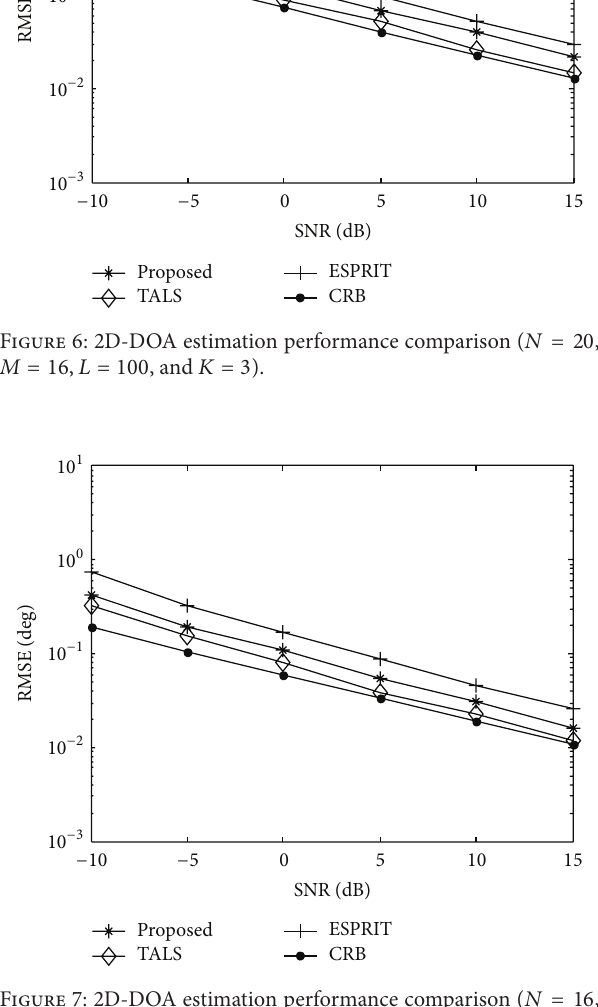
Figure 7: 2D-DOA estimation performance comparison ( 𝑁 = 16 , 𝑀 = 16 , 𝐿 = 200 , and 𝐾 = 3